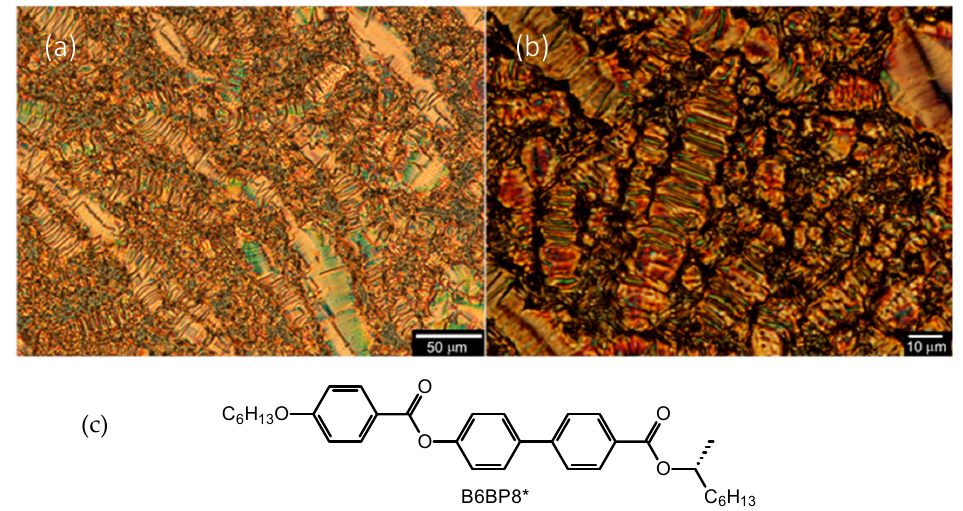
Figure 5. POM images of the SmC*–LC–poly(Ar–Pyr) blend with the chiral inducer, C6BPC8*, at different sections of the same sample. ( a ) Low magnification. ( b ) High magnification image. ( c ) chemical structure of B6BP8* as a chiral inducer.